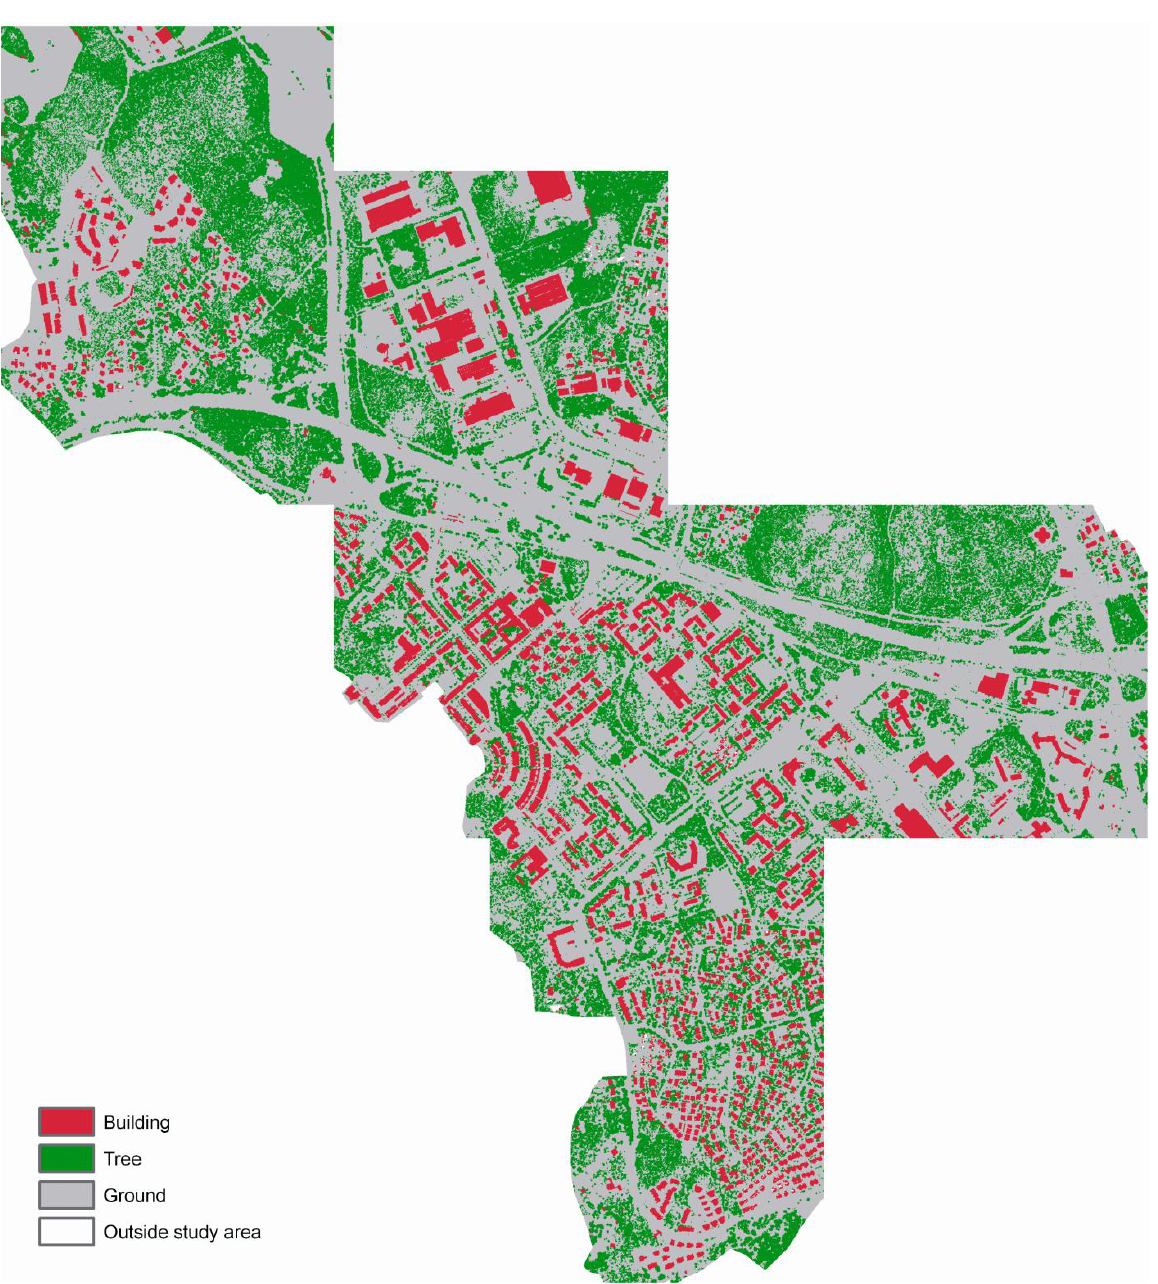
Figure 5. Building detection results for the test